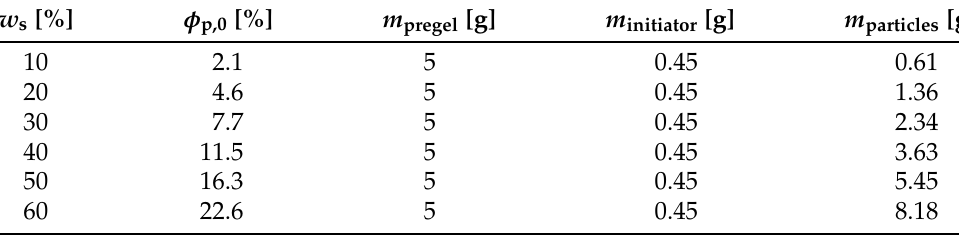
Table 1. Composition of synthesized magnetorheological gels. w s and φ p,0 denote the mass and volume fraction of the particles in the initial state of